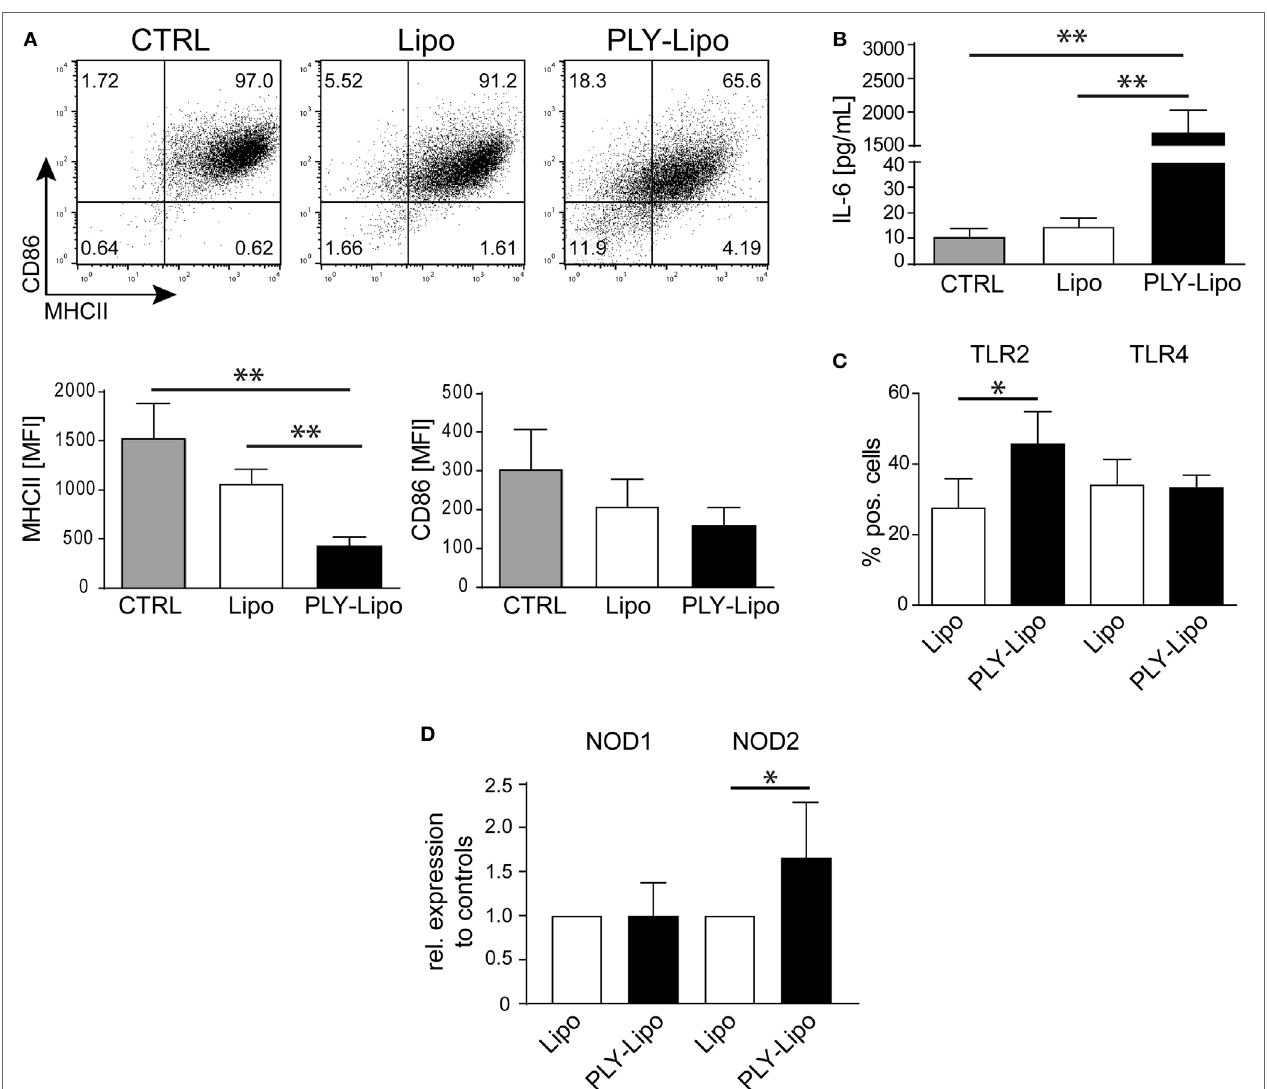
FigUre 3 | Pneumolysin (PLY)-bearing liposomes induce phenotypic changes in human macrophages in vitro . PLY-bearing liposomes (PLY-Lipo) were produced by pre-incubation of 40 µg/ml cholesterol:sphingomyelin liposomes with 4 µg/ml PLY for 10 min at room-temperature. This protocol efficiently sequesters the total amount of added toxin and neither cytotoxicity nor binding of free PLY to cultured cells is observed (see Figure 2a ). (a) PLY-liposomes induce a downregulation of MHCII and CD86 in macrophages. Day 7 M-CSF differentiated human macrophages were stimulated with PLY-liposomes (PLY-Lipo), liposomes without PLY (Lipo) or left untreated (CTRL) and analyzed by FACS gated for CD14 + macrophages after 48 h. PLY-Lipo stimulated macrophages showed a marked downregulation of MHCII and CD86 as compared to control cells (untreated or liposomes only; Lipo). A representative FACS blot of one of three independent experiments is shown. Mean fluorescence intensity of MHCII and CD86 of CD14 + gated cells of three independent experiments are shown (mean ± SD, n = 5; * p < 0.05; unpaired t -test; two-tailed). (B) PLY-liposomes induce IL-6 production in macrophages. Human macrophages were stimulated as in (a) and IL-6 production was determined after 48 h from culture supernatants performing Bio-Plex assays (BioRad). IL-6 production is shown to be significantly enhanced in PLY-Lipo stimulated macrophages (mean ± SD; n = 7; ** p < 0.005; unpaired t -test; two-tailed). (c) PLY-liposomes induce TLR2 expression in macrophages. Day 7 M-CSF differentiated human macrophages were stimulated with PLY-Lipo or liposomes only (Lipo) and analyzed by FACS gated for CD14 + macrophages after 48 h. PLY-Lipo stimulated macrophages showed a significant increase in TLR2 as compared to control cells (liposomes only; Lipo). Percentages of TLR2- and TLR4- expressing CD14 + macrophages are shown (mean ± SD; n = 6; * p < 0.05; paired t -test; two-tailed). (D) PLY-liposomes induced macrophages express increased levels of NOD2. Day 7 M-CSF differentiated human macrophages were stimulated with PLY-Lipo or liposomes only (Lipo) for 48 h. RNA was isolated and RT-PCR was performed to analyze expression levels of NOD1 and NOD2 in these cells. PLY-liposome induced macrophages showed a significant increase in NOD2 expression as compared to control cells (liposomes only; Lipo). NOD1 levels remained unchanged (mean ± SD; n = 7; * p < 0.05; paired t -test;